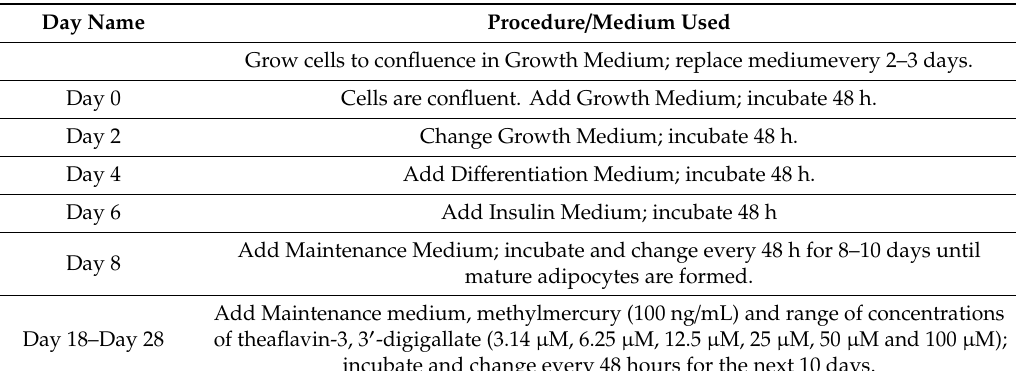
Table 2. Cell Culture Protocol.